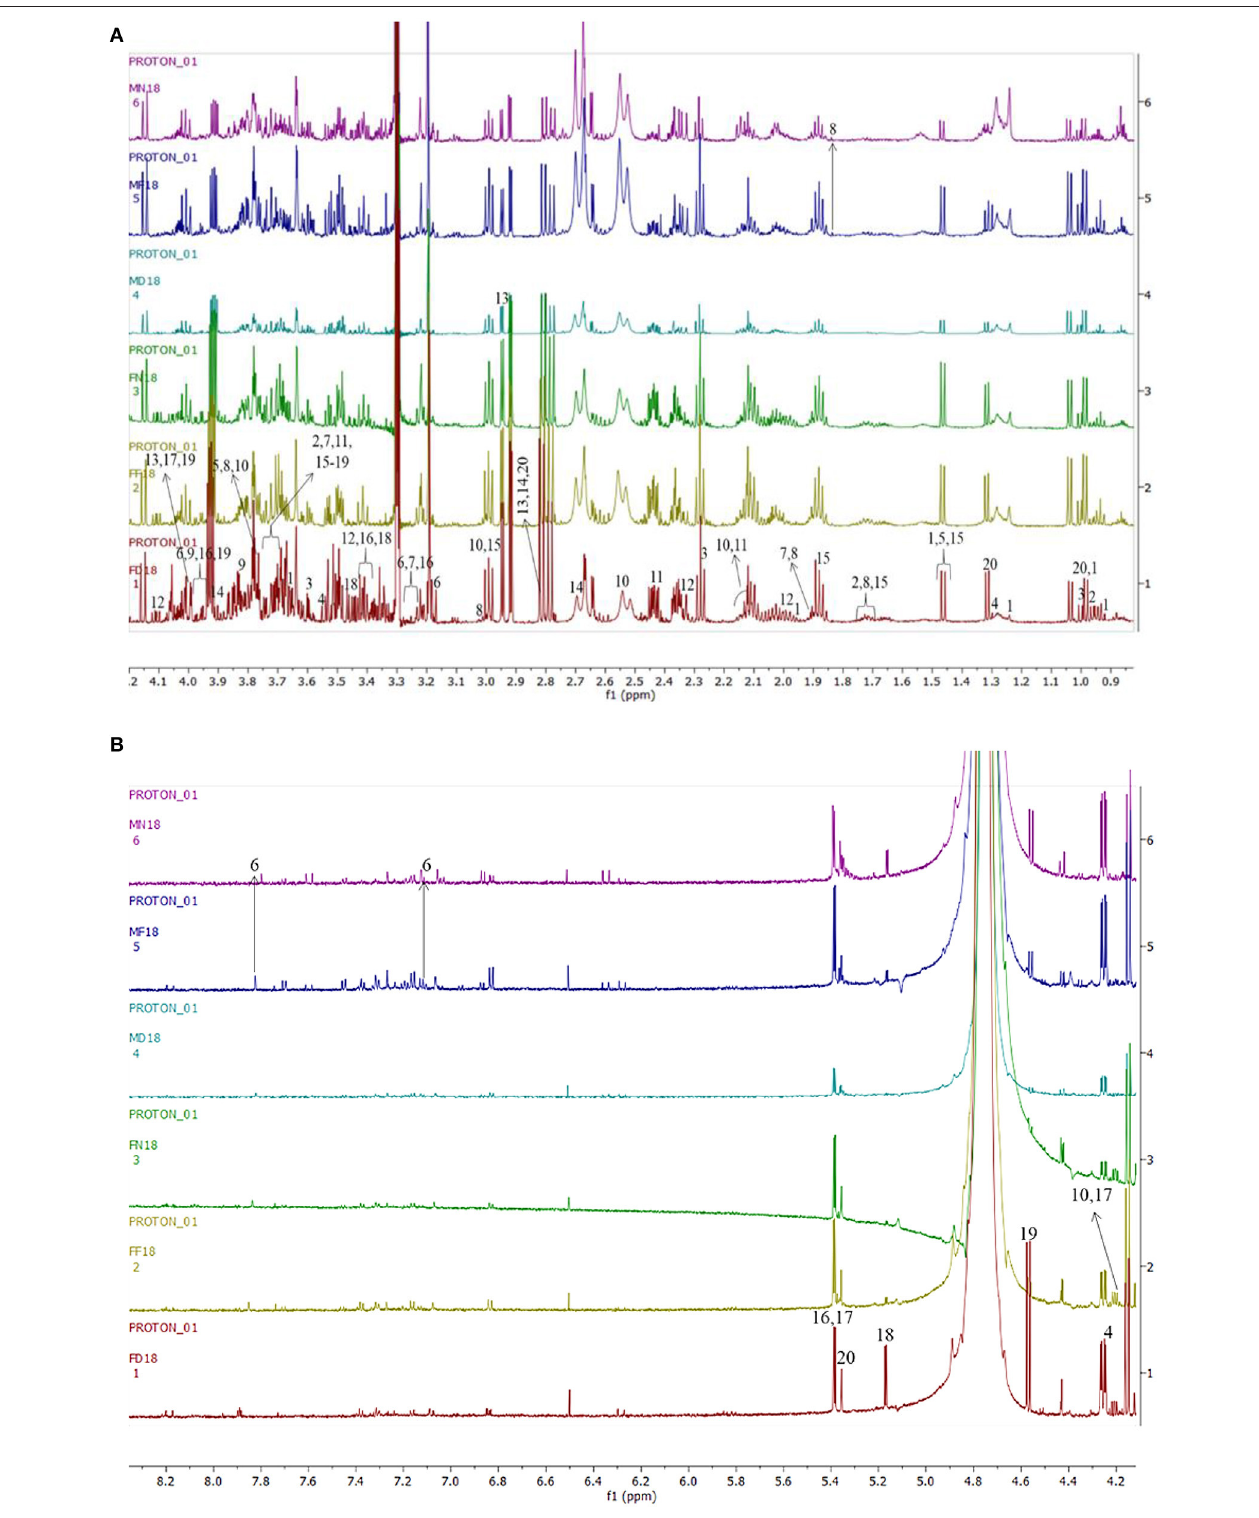
FIGURE 2 | (A) Annotated NMR spectra of the compounds used for metabolite identification in samples of Fianna and Markies potato cultivars that received control or flooding or drought irrigation treatments. (B) Annotated NMR spectra of the compounds used for the metabolite identification in samples of Fianna and Markies potato cultivars that received control, flooding or drought irrigation